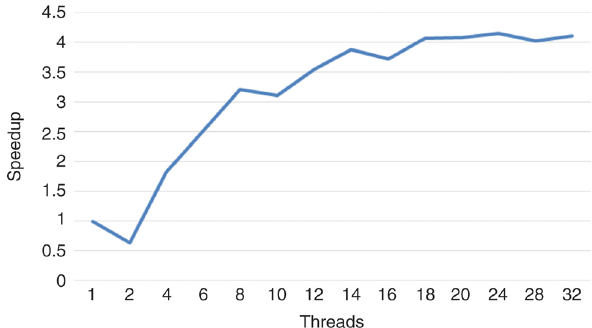
Figure 7: Performance (measured in cells processed per second) gain with respect to the best known sequential imple- mentation.